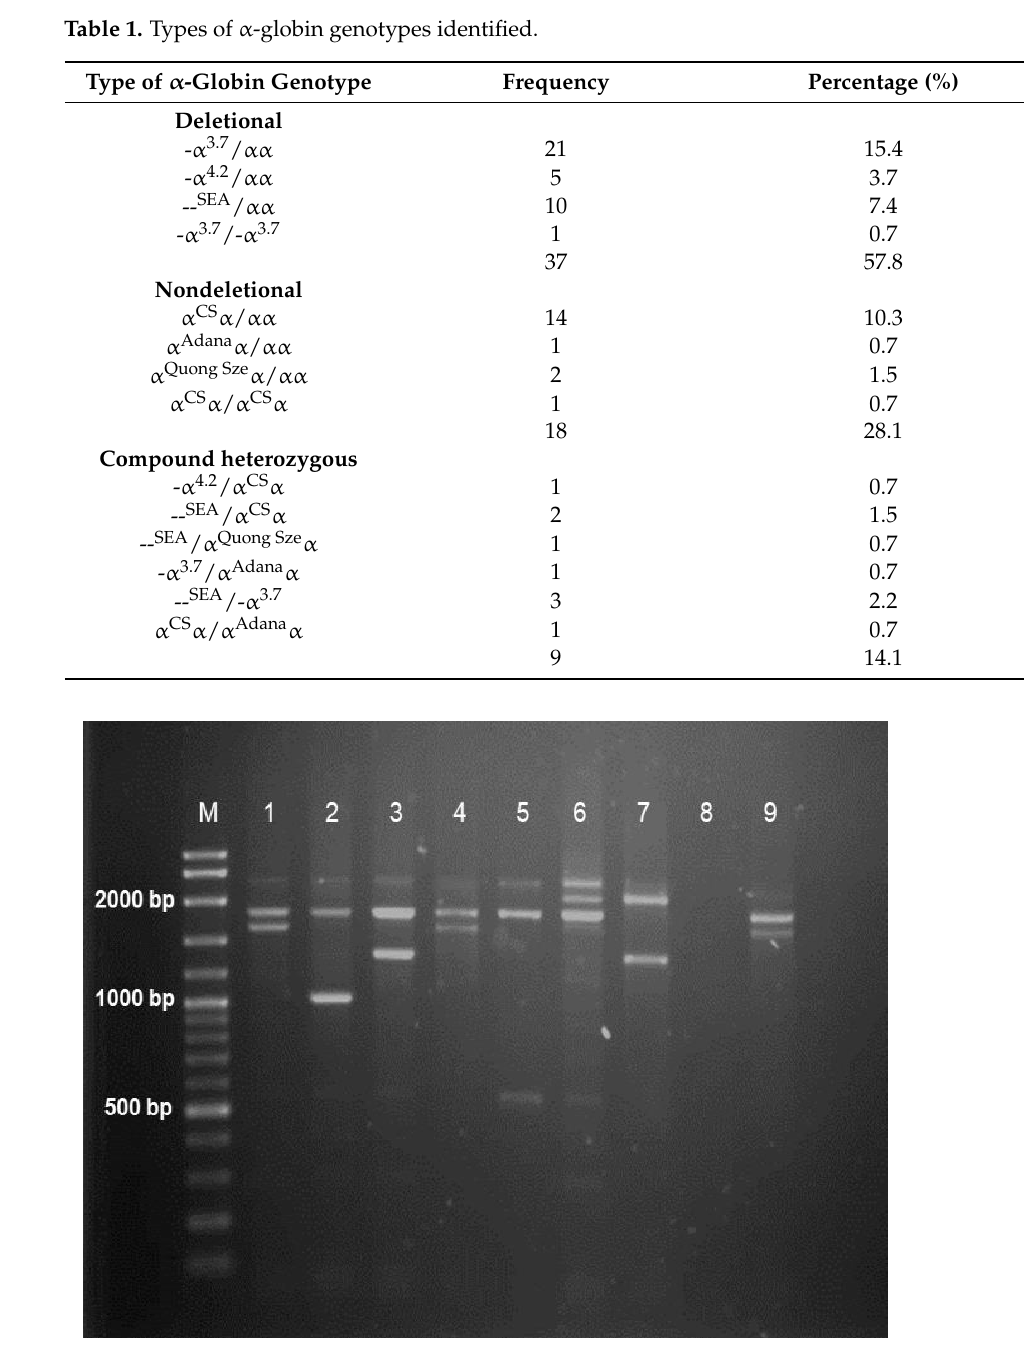
Figure 1. Representative gel image for α deletional mutations : Lane M: 100 bp plus ladder; Lane 1: heterozygous 4.2 mutation (- α 4.2 /αα); Lane 2: heterozygous 20.5 mutation (- α 20.5 /αα); Lane 3: heterozygous SEA mutation (-- SEA /αα); Lane 4: heterozygous 4.2 mutation (- α 4.2 /αα); Lane 5: heterozygous Fil mutation (-- FIL /αα); Lane 6: heterozygous 3.7 mutation (- α 3.7 /αα); Lane 7: compound heterozygous (-- SEA /- α 3.7 ); Lane 8: negative control; Lane 9: heterozygous 4.2 mutation (- α 4.2 /αα).